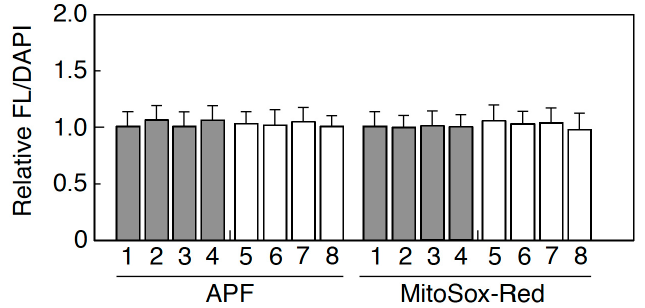
Figure 4. Oxidative stress levels in ADSCs. Intracellular oxidative stress level was measured by APF, and mitochondrial damage was quantified by MitoSox-Red. Gray boxes indicate the mean amount observed in the cells from HIV-uninfected patients, while white boxes indicate that observed in the cells obtained from HIV-infected patients. Bars indicate S.D.